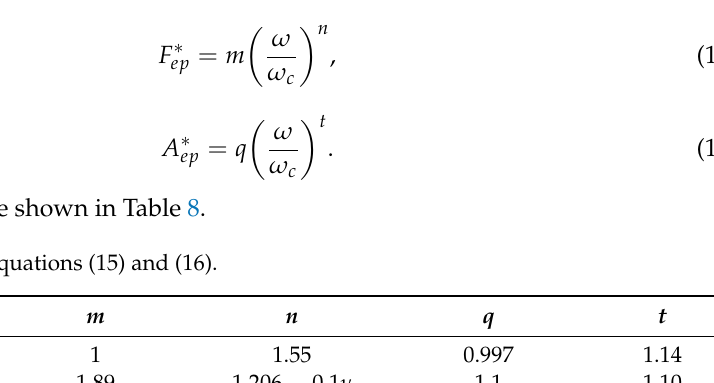
Table 8. Parameters in Equations (15) and (16).